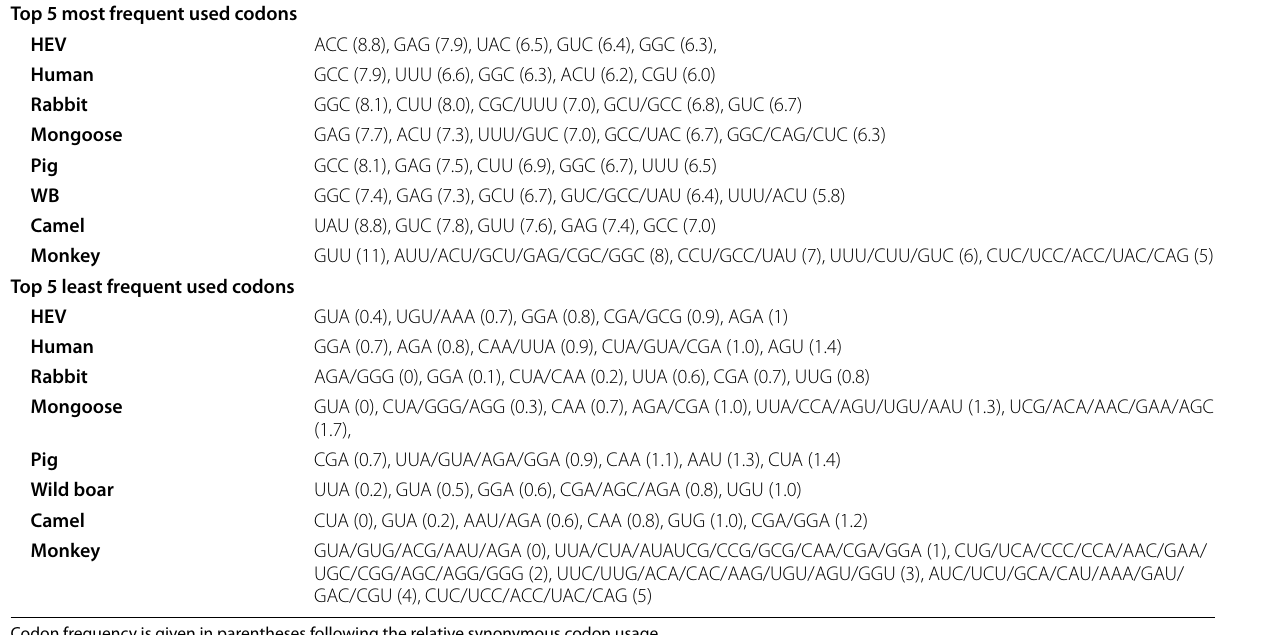
Codon frequency is given in parentheses following the relative synonymous codon usage